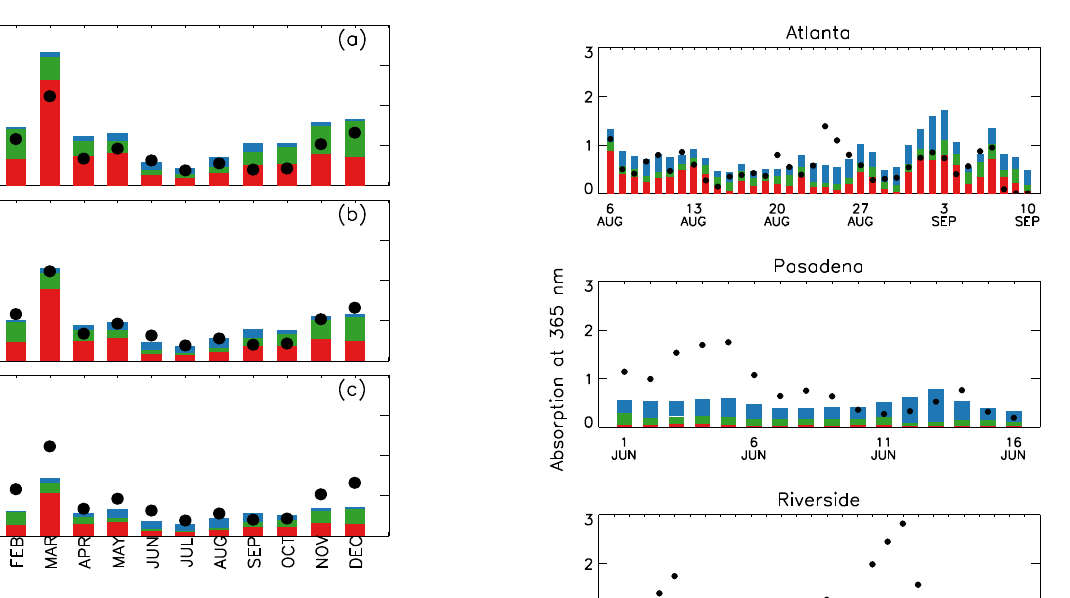
Figure 3. Simulated versus observed monthly mean light absorp- tion at 365nm by water-soluble BrC over the southeastern United States in 2007. Unit is Mm − 1 . Black circles denote observations, and bar graphs indicate model results for each source: biomass burning (red), biofuel (green), and SOC (blue). Each panel shows the comparisons with different emission estimate cases – (a) case 1, (b) case 2, and (c) case 3.